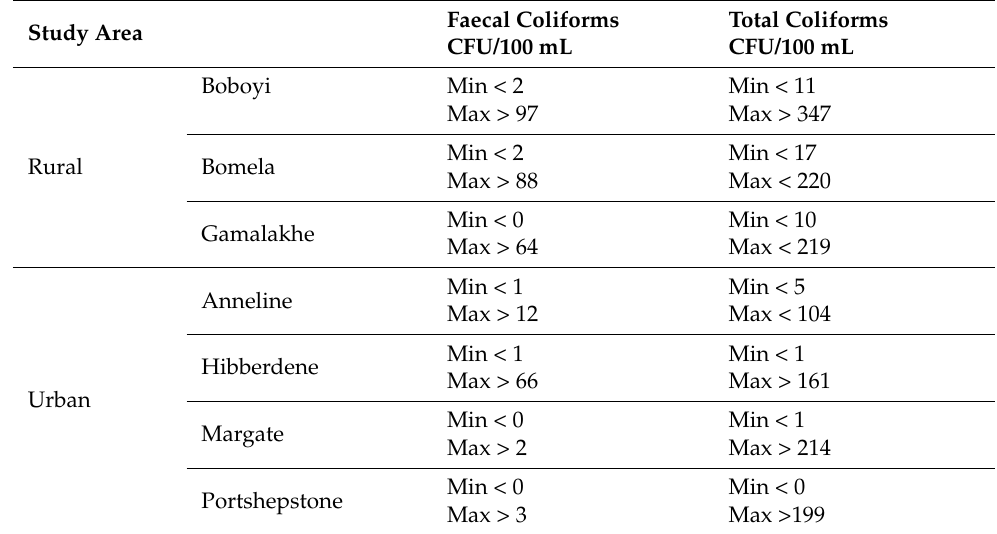
Table 2. Overall microorganism counts detected in drinking water samples in the study